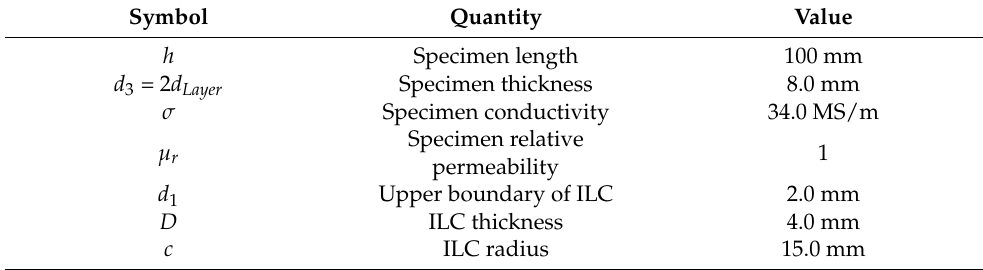
Table 2. Parameters of the